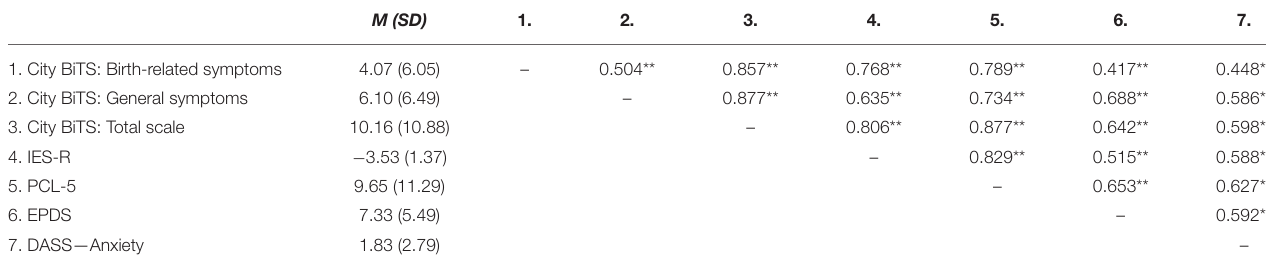
TABLE 4 | Intercorrelations of the City BiTS (subscales and total scale) with measures of PTSD symptomatology, depression, and anxiety ( N = 1,072).